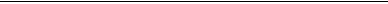
Figure 13 . Di(cid:11)erential angularity distributions for a = entire (cid:28) a domain. The distributions correspond to NLL 0 + (purple) accuracy with renormalon subtractions, and they are either obtained as the derivative of the integrated distributions (left) or directly resummed as di(cid:11)erential distributions (right). As expected from the analysis in [35], the former show a bit better convergence than the